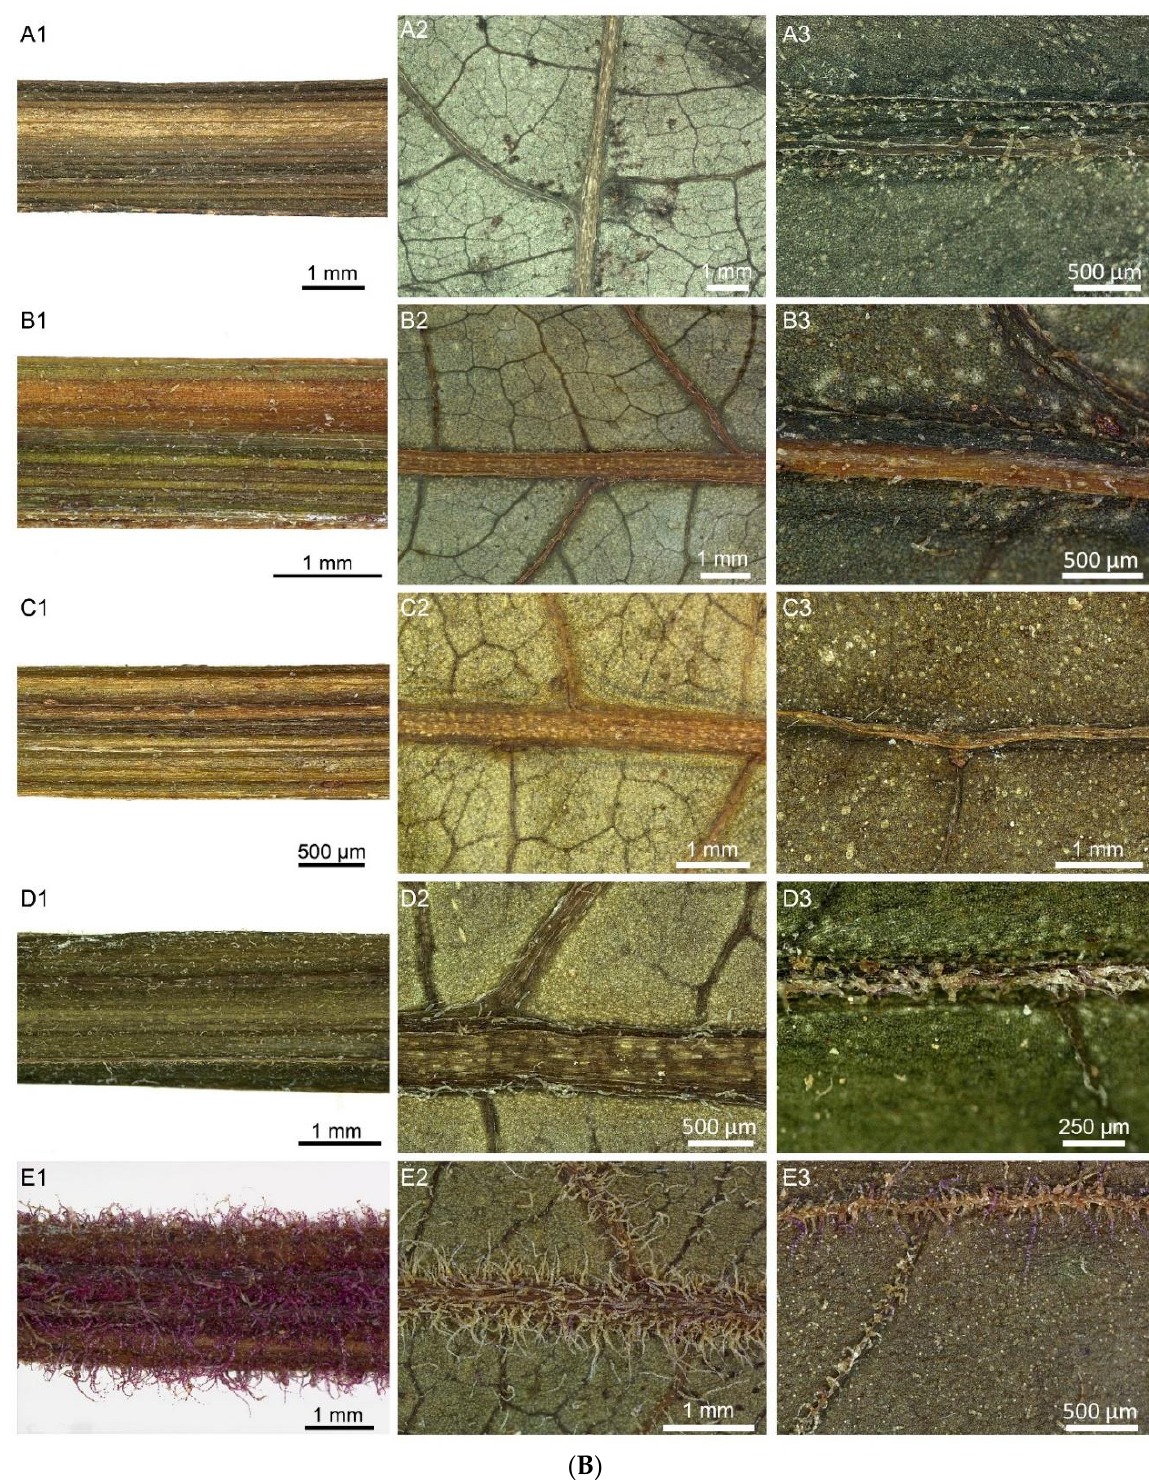
Figure 2. ( A ) Morphological variations of trichomes in Causonis . A , C. clematidea . B , C. timoriensis var. mekongensis , CPG32937. C , C. trifolia , LA17. D , C. maritima . E , C. fugongensis . Trichomes ’ morphologies on branchlets, abaxial, and adaxial surfaces of leaves are shown from left to right, respectively. ( B ) Morphological variations of trichomes in Causonis . A , C. japonica var. japonica . B , C. japonica var. pseudotrifolia . C , C. corniculata . D , C. daliensis . E , C. mollis . Trichomes ’ morphologies on branchlets, abaxial, and adaxial surfaces of leaves are shown from left to right, respectively.